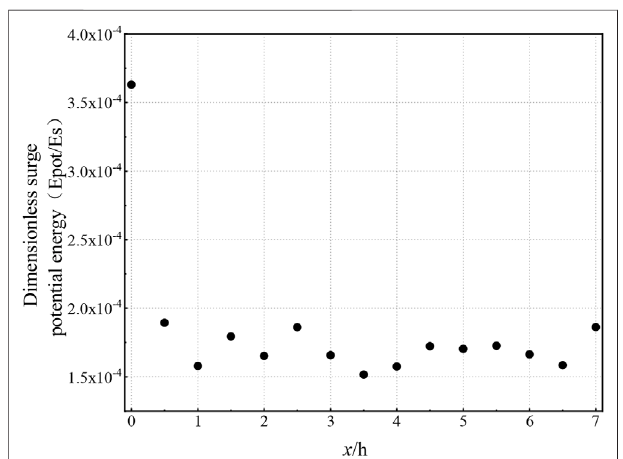
FIGURE 5 | Variations of surge potential energy E pot vs. distance x/h for quadratic parabolic shaped slide